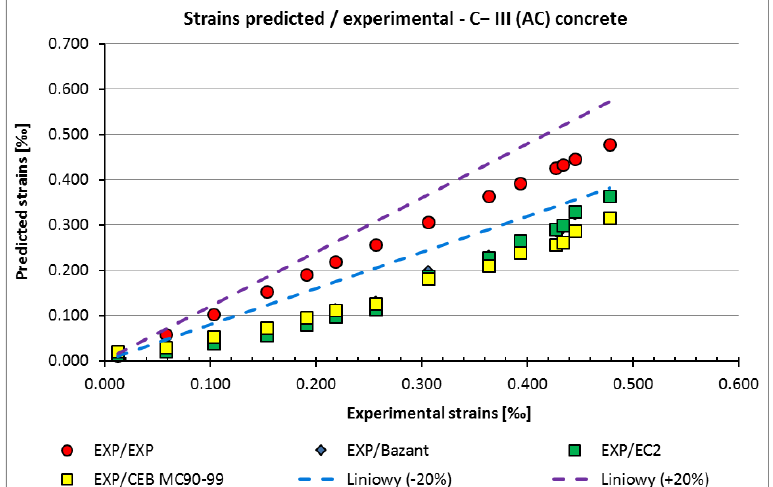
Figure 6. The strain results of non-cured C − III (AC) samples.